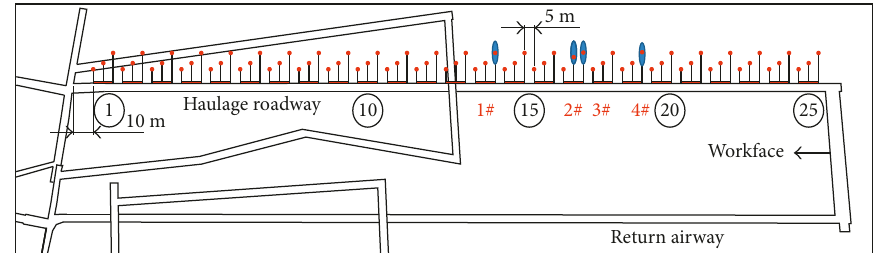
Figure 8: Layout diagram of stress online monitoring and measuring system in haulage roadway.